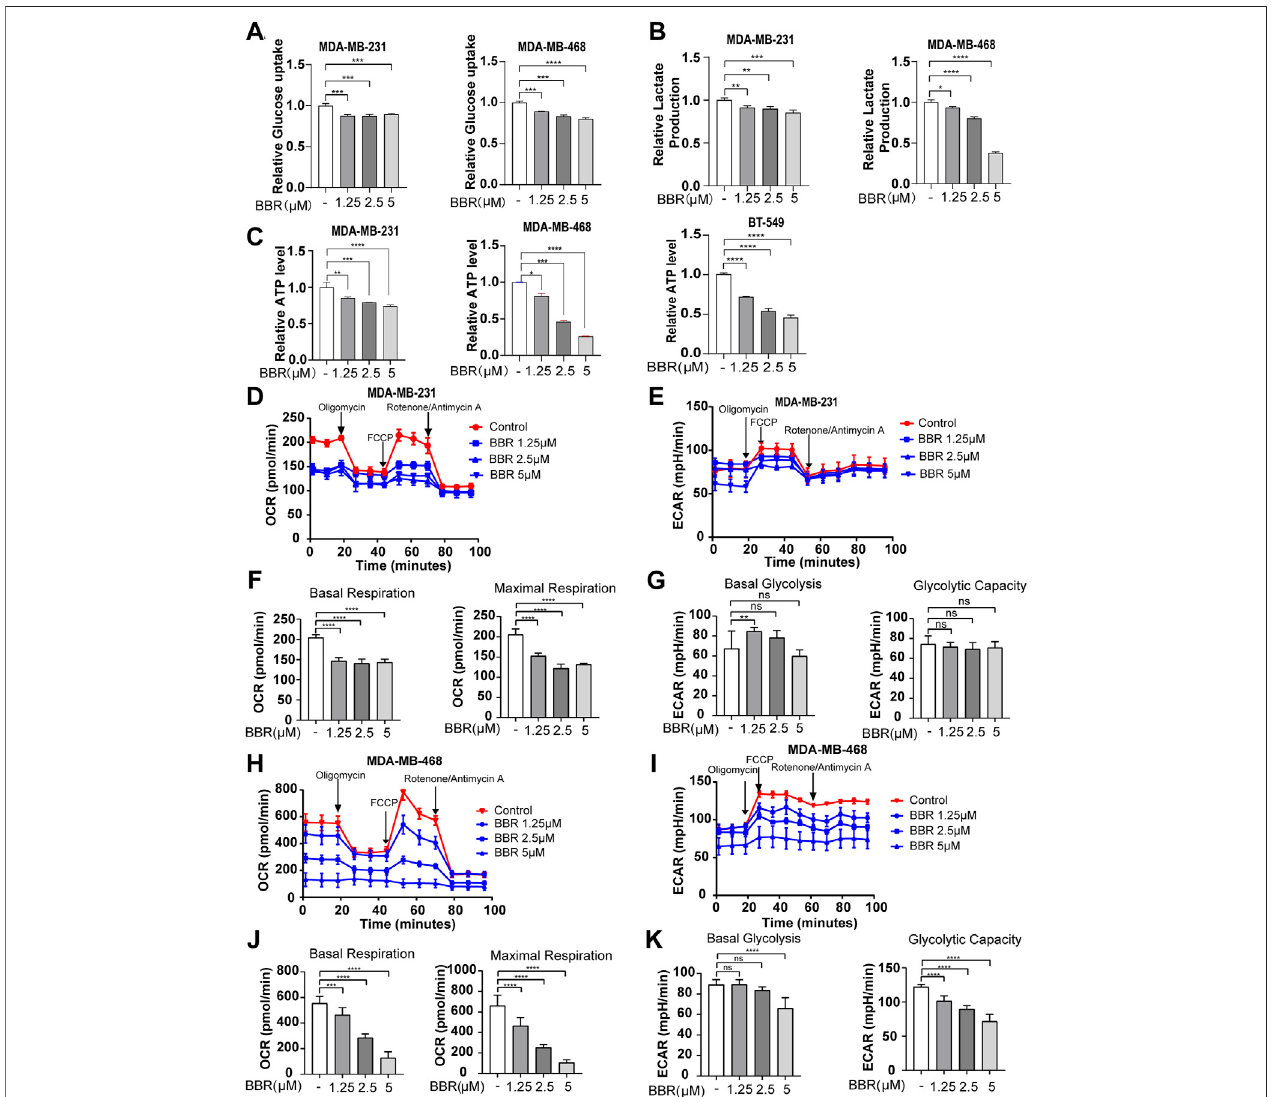
FIGURE 2 | Berberine dampens glycolysis in the TNBC cells. (A – C) . Glucose uptake, lactate secretion, and ATP generation level in the TNBC cells after the treatment with berberine (1.25, 2.5, and 5 μ M) for 48 h (D – E,H – I) . Effects of berberine on the oxygen consumption ratio (OCR) and extracellular acid ratio (ECAR) in MDA-MB-231 and MDA-MB-468 cells. The TNBC cells were treated with berberine for 48 h, then the cells were collected for the OCR and ECAR as determined by the SeahorseXF24. (F,J) .ThebasalrespirationandmaximalrespirationcapacityoftheTNBCcellswithberberinetreatmentwereanalyzedbyusingGraphPadPrism8 software. (G,K) The basal glycolysis and glycolytic capacity of the TNBC cells with berberine treatment were analyzed by GraphPad Prism 8 software. The data are presented as the mean ± S.D. of at least three independent measurements. ** p < 0.01, *** p < 0.001, **** p < 0.0001 vs. the control